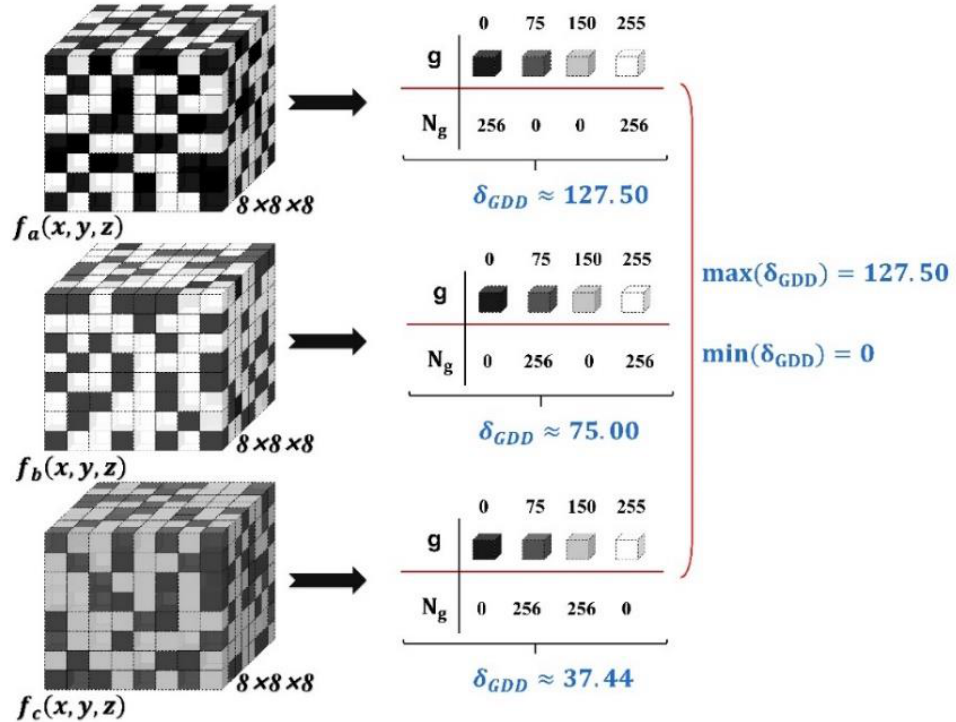
Figure 6. The principle of GDD: f GDD 127.50, 75.00, corresponding to 𝜹